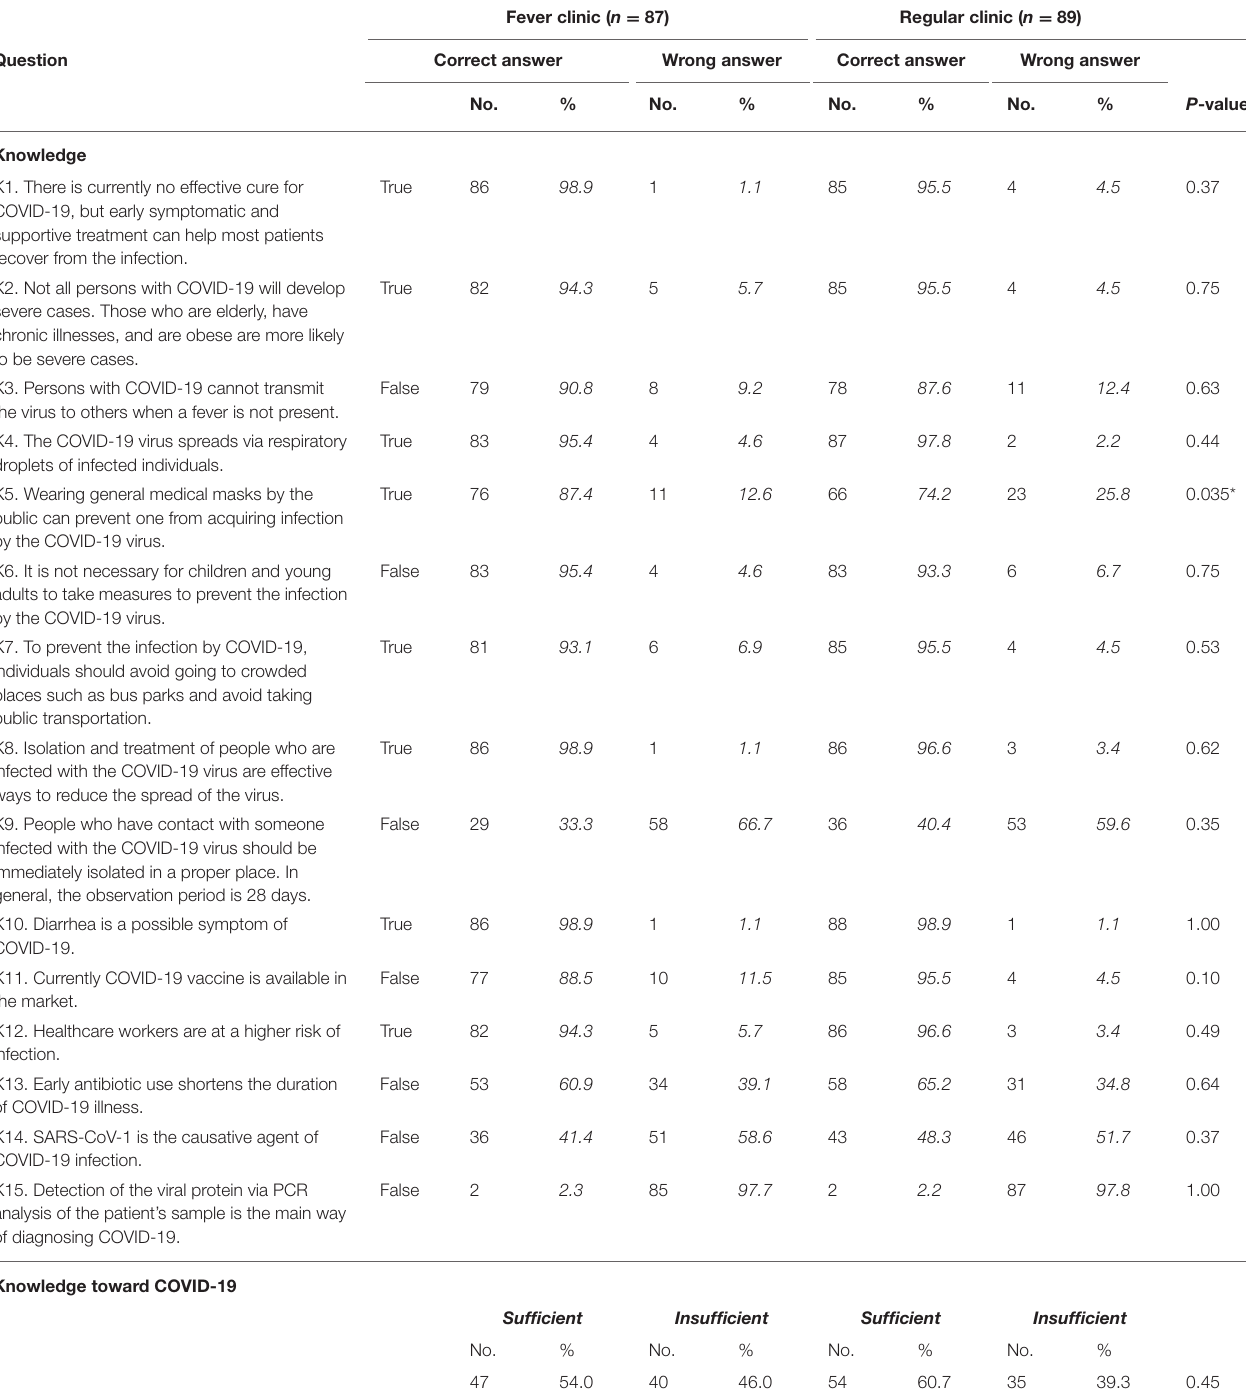
TABLE 3 | Knowledge scores regarding COVID-19 amongst healthcare workers in fever compared to regular primary care clinics ( n = 176). Fever clinic ( n = 87) Regular clinic ( n = 89) Question Correct answer Wrong answer